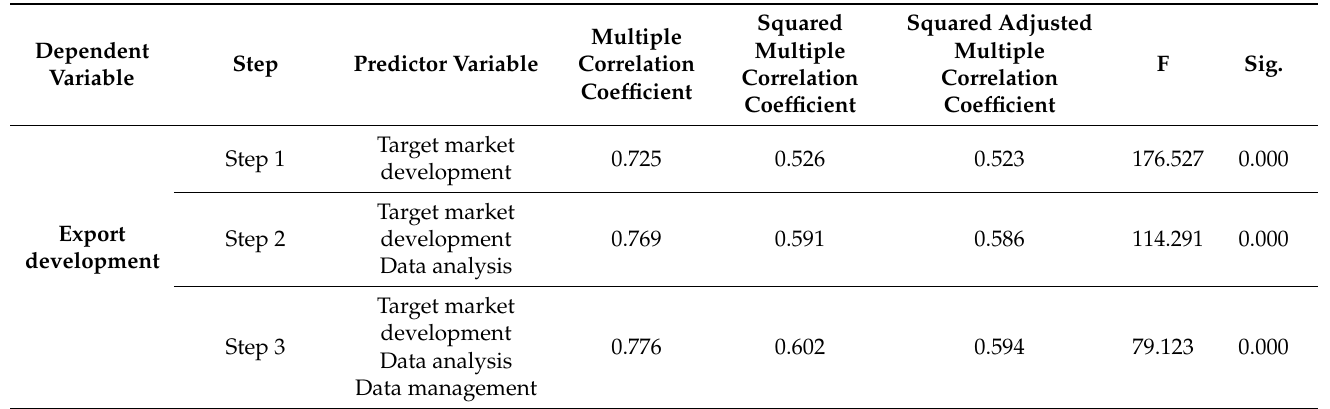
Table 6 indicates that the beta coefficient increases export development by 0.512 units per unit increase in target market development, by 0.221 units per unit increase in data analysis, and by 0.157 units per unit increase in data management. The prediction equation is presented as follows: